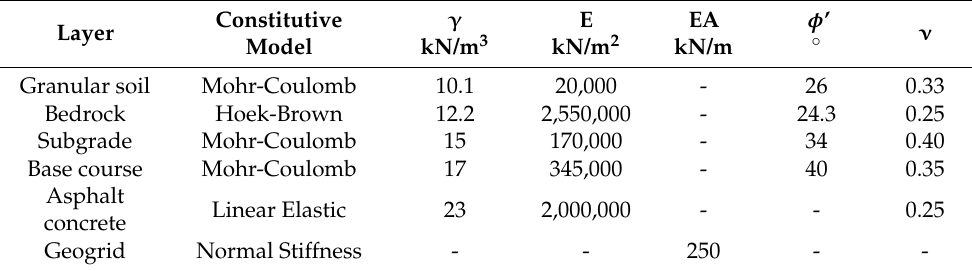
Table 3. Geotechnical parameters used in FEM for the different